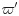
(a) Performance of the optimal weighting ϖ′ from 0 to 0.5 between the intensity measures and gradient measures on the Middlebury “Tsukuba” dataset. (b) Performance of a
1 and a
2 on the Middlebury “Tsukuba” dataset.